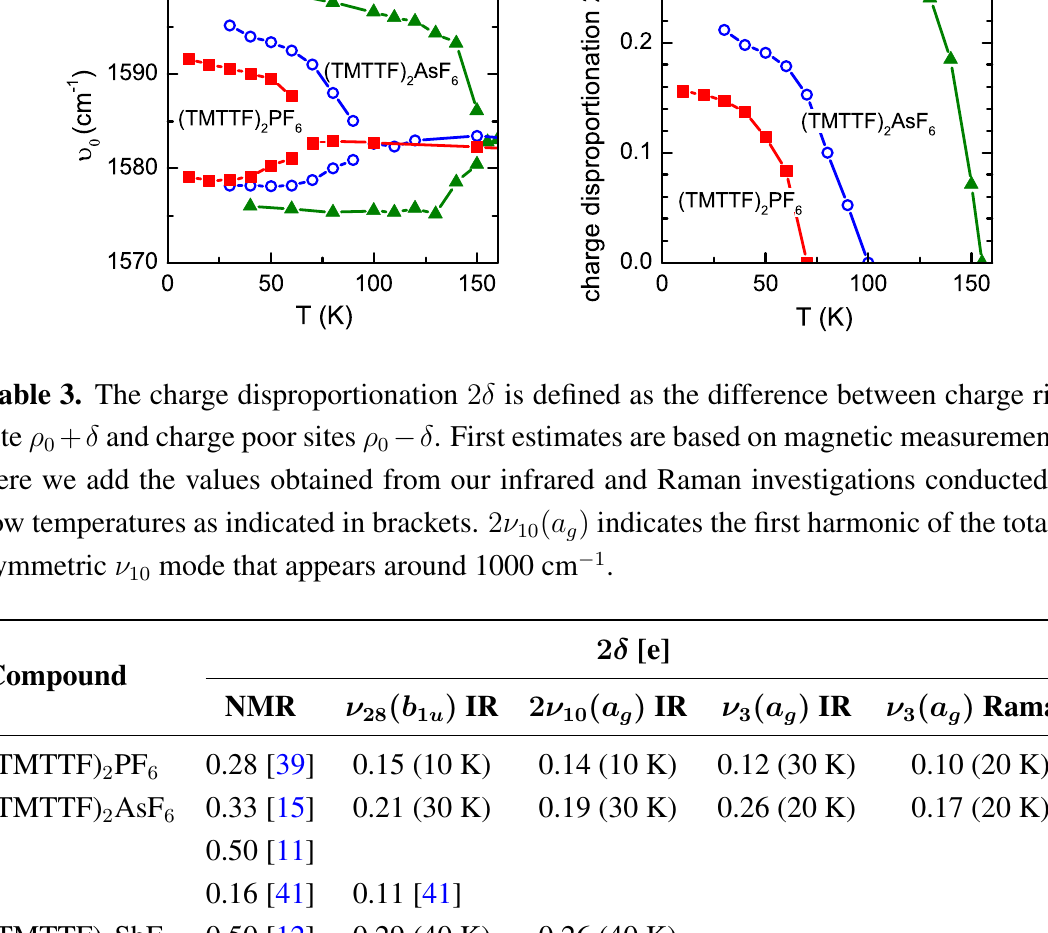
Figure 12. ( a ) Position of the peaks for the (TMTTF) as a function of T recorded along the c axis; ( b ) Temperature dependence of the charge dispropotionation probed by the splitting of the ν estimated from the difference of the two resonance frequencies by Equation 2.